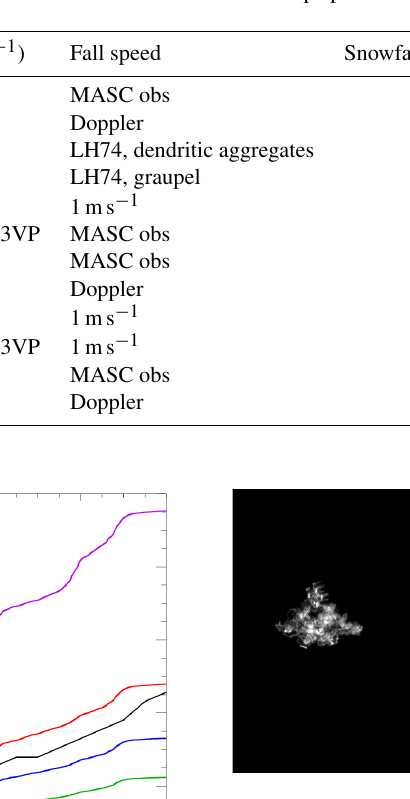
Figure 8. Typical rimed and graupel-like particles observed by the MASC on 15